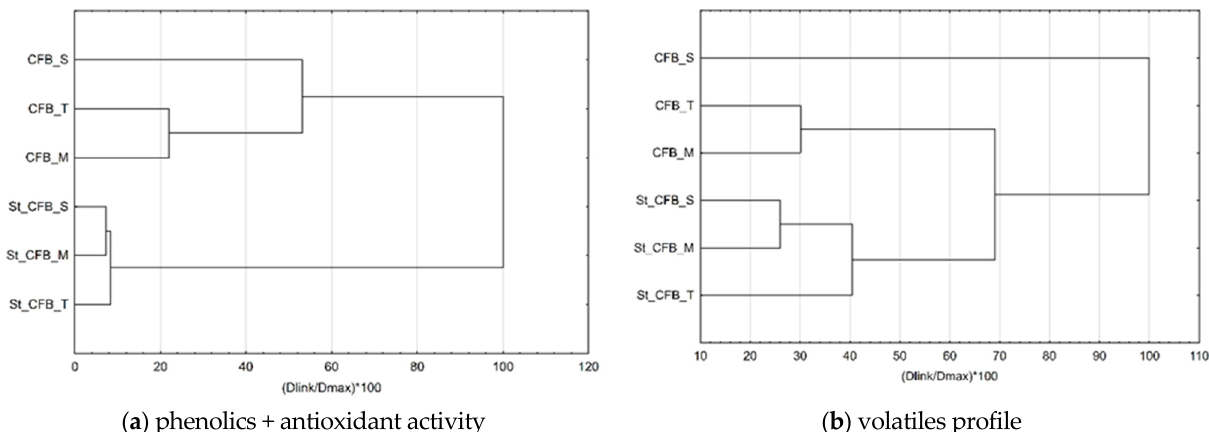
Figure 2. Cluster analysis of similarity of samples according to phenolics and antioxidant activity ( a ) and volatiles profile ( b ) (CFB—citrus fiber-blackberry cream fillings; S—sucrose; M—maltose; T—trehalose; St—storage).